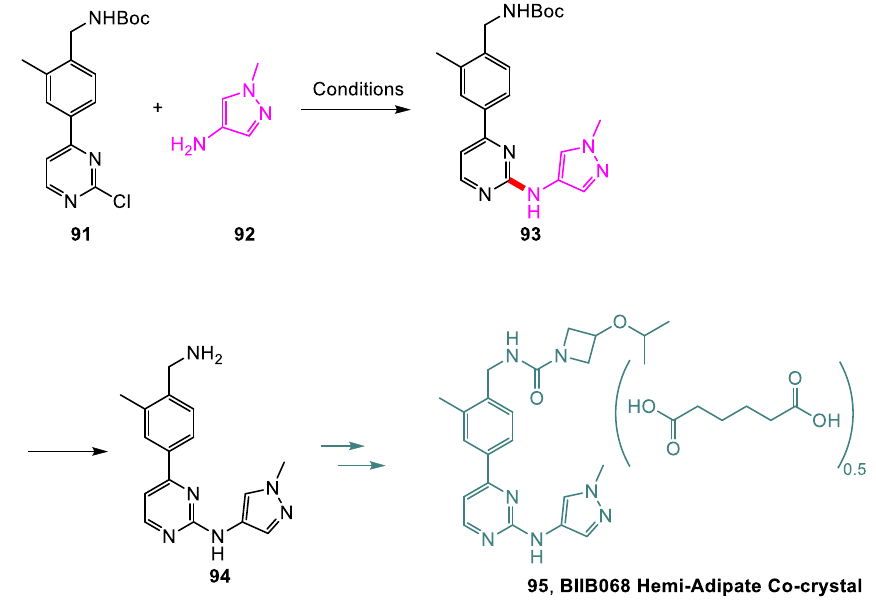
Table 1. Selected screening results for the C-N coupling of 91 with 92.